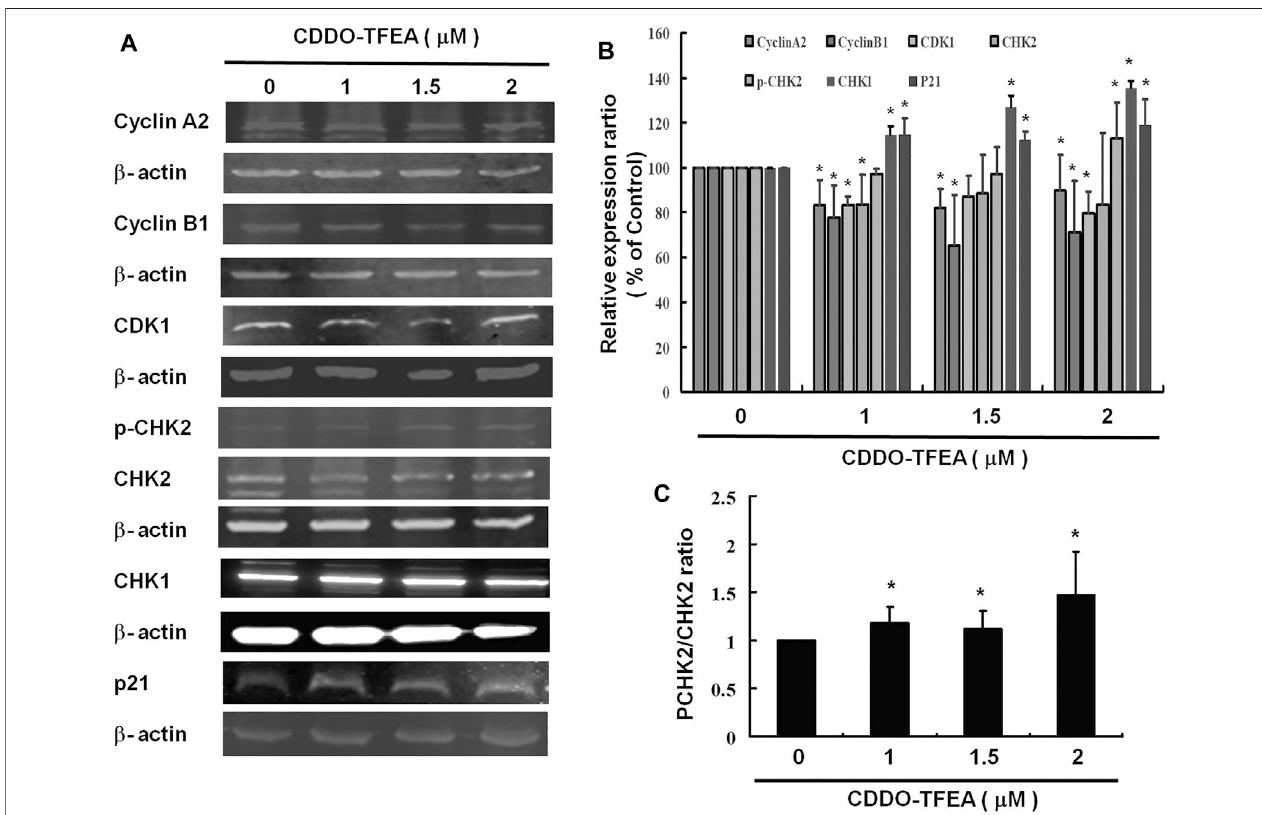
FIGURE7|(A) CDDO-TFEAregulatedcellcycle – relatedgeneexpressionincyclinA2,cyclinB1,andCDK1,aswellasapoptosis-(p21-)relatedgeneexpressionin the GBM8401 cells. Cells were treated with CDDO-TFEA for 24 h. Gene and protein expression was subsequently detected through Western blotting. (B) Results are expressedasapercentageofthecontrol,withthecontrolbeing100%.Alldataarereportedasmeans ± standarderrorsofthemeanonthebasisoftheresultsofatleast threeseparateexperiments.Statisticalanalysiswasperformedusingthe t test,withdifferencesbetweenthetreatmentandcontrolgroupsconsideredsigni fi cantat p < 0.05, as denoted by